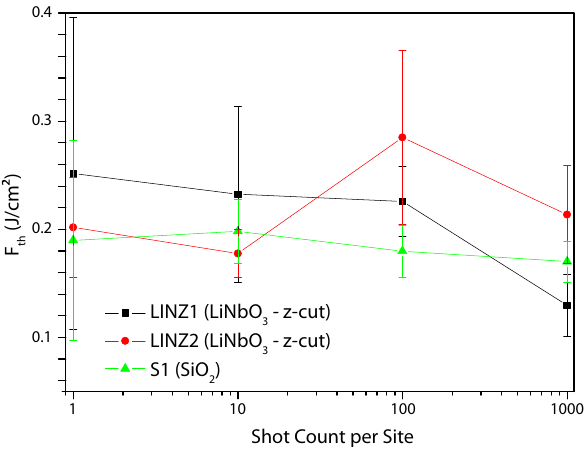
∼ 30nm nano- Figure 8: LID thresholds of a single layer of spheres in dependence of shot number. Three samples with differ- (cid:31) ent substrate materials were